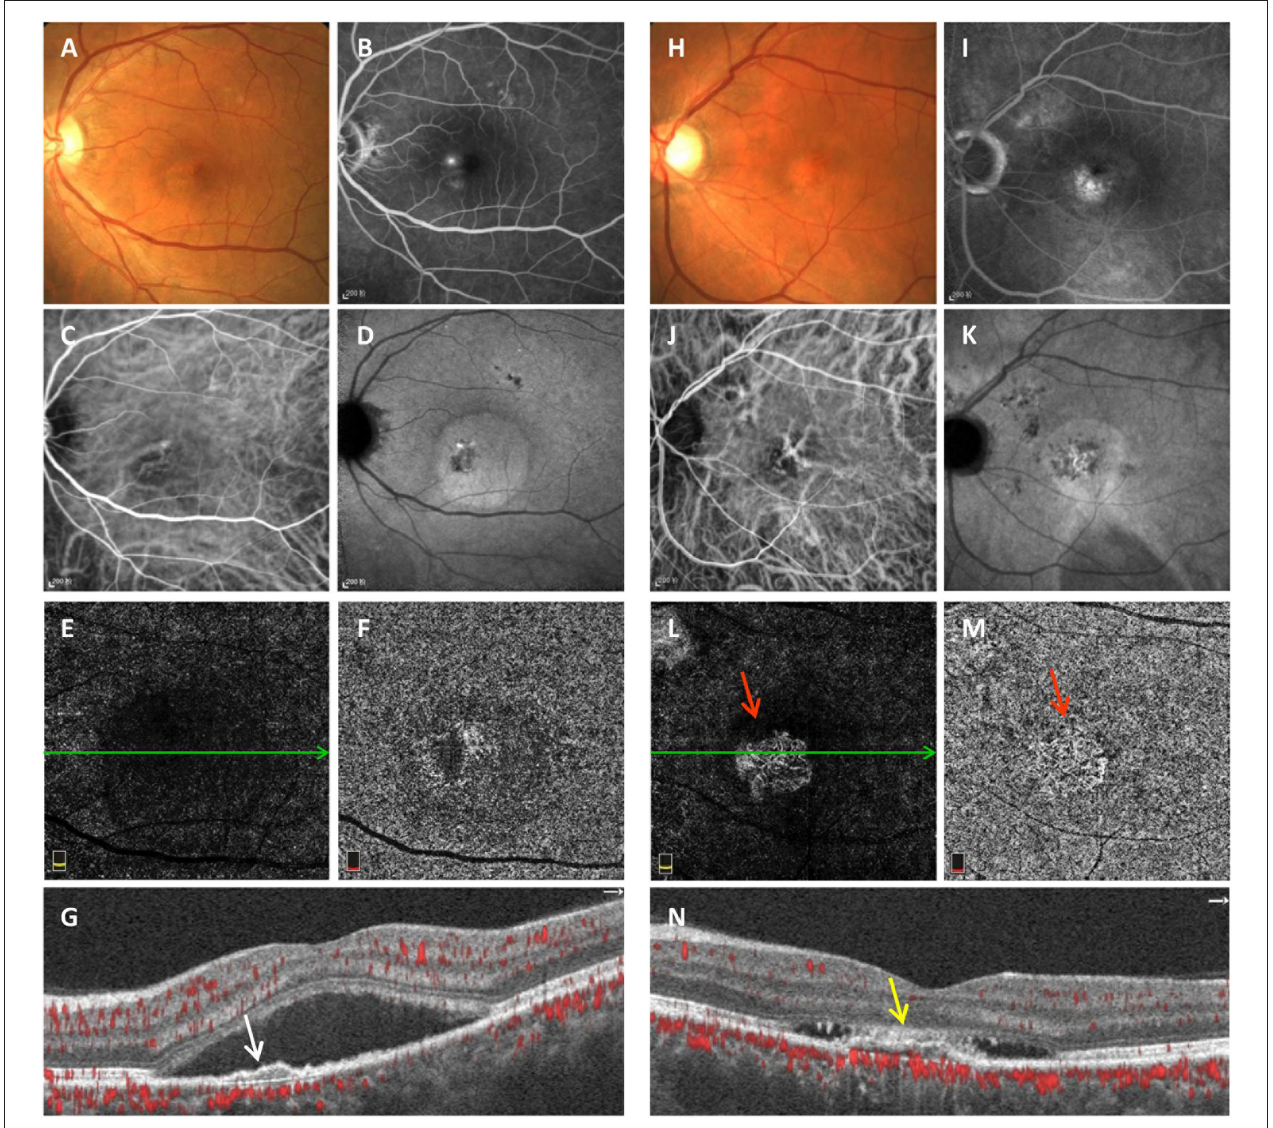
FIGURE 1 | Multimodal imaging of avascular (A–G) and vascularized FIPED (H–N) in chronic CSC. Fundus photography (A) of avascular FIPED showed retinal neurosensory detachment in the macula. “Ink spots” dye leakage was observed on FFA (B) . ICGA showed dilation of choroidal vessels in the macular region in the early phase (C) and ovoid hyperfluorescence in the macula corresponding to retinal neurosensory detachment in the late phase (D) . No CNV signals were observed on ICGA (C,D) , in the outer retina layer (E) or choriocapillaris layer on OCTA (F) , or on cross-sectional OCTA [ (G) , corresponding to the green line in (E) ]. Cross-sectional OCTA showed that FIPED [white arrow in (G) ] presented as an irregular elevation of the RPE. Fundus photography (H) of vascularized FIPED showed multifocal abnormal pigmentation. Dye leakage was observed on late-phase FFA (I) . Choroidal vessel dilation was shown in the macular region on early-phase ICGA (J) , but the choroidal neovascular network was not clearly shown. Both en face OCTA [red arrow in (L,M) ] and cross-sectional OCTA [ (N) , corresponding to the green line in (L) ] showed CNV signals in vascularized FIPED [yellow arrow in (N) ]. FIPED, flat irregular pigment epithelial detachment; CSC, central serous chorioretinopathy; FFA, fundus fluorescein angiography; ICGA, indocyanine green angiography; CNV, choroidal neovascularization; OCTA, optical coherence tomography angiography; RPE, retinal pigment epithelium.